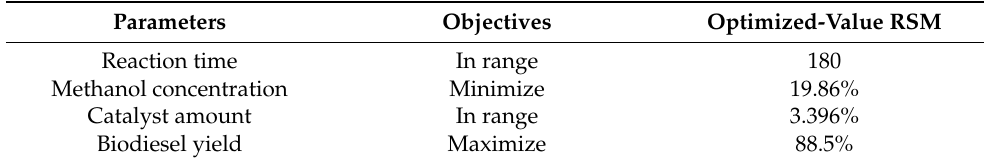
Table 7. Optimizing parameters for the optimal biofuel